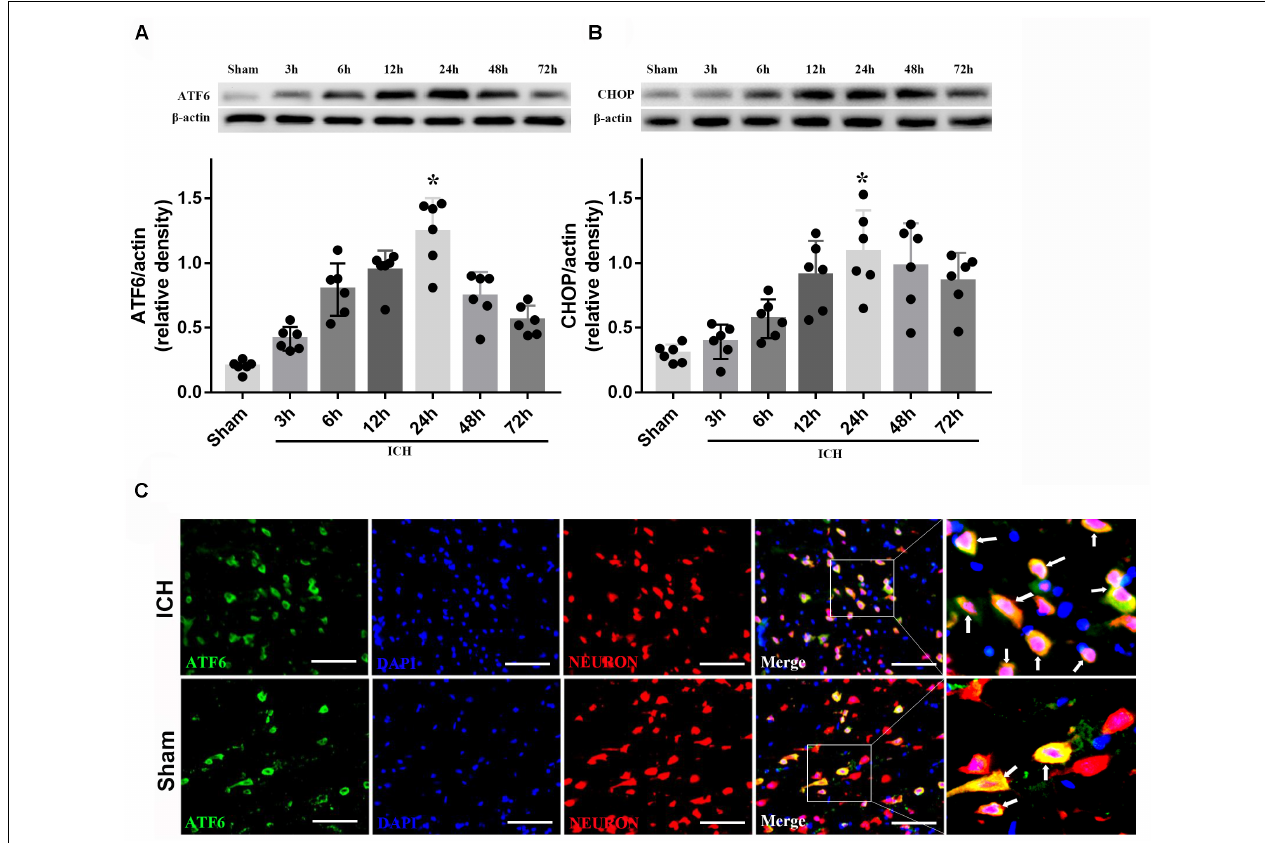
FIGURE 3 | Expression of ATF6 and CHOP. (A) Time course of ATF6 in injured hemisphere after ICH; (B) time course of CHOP; n = 6 for each group. The bars represent the mean ± SD. ∗ p < 0.05 vs. sham; (C) Representative microphotographs of immunofluorescence staining showing localization of ATF6 (green) and NeuN (red) in the perihematomal region after ICH ( N = 2 for each group). Scale bar = 50 µ